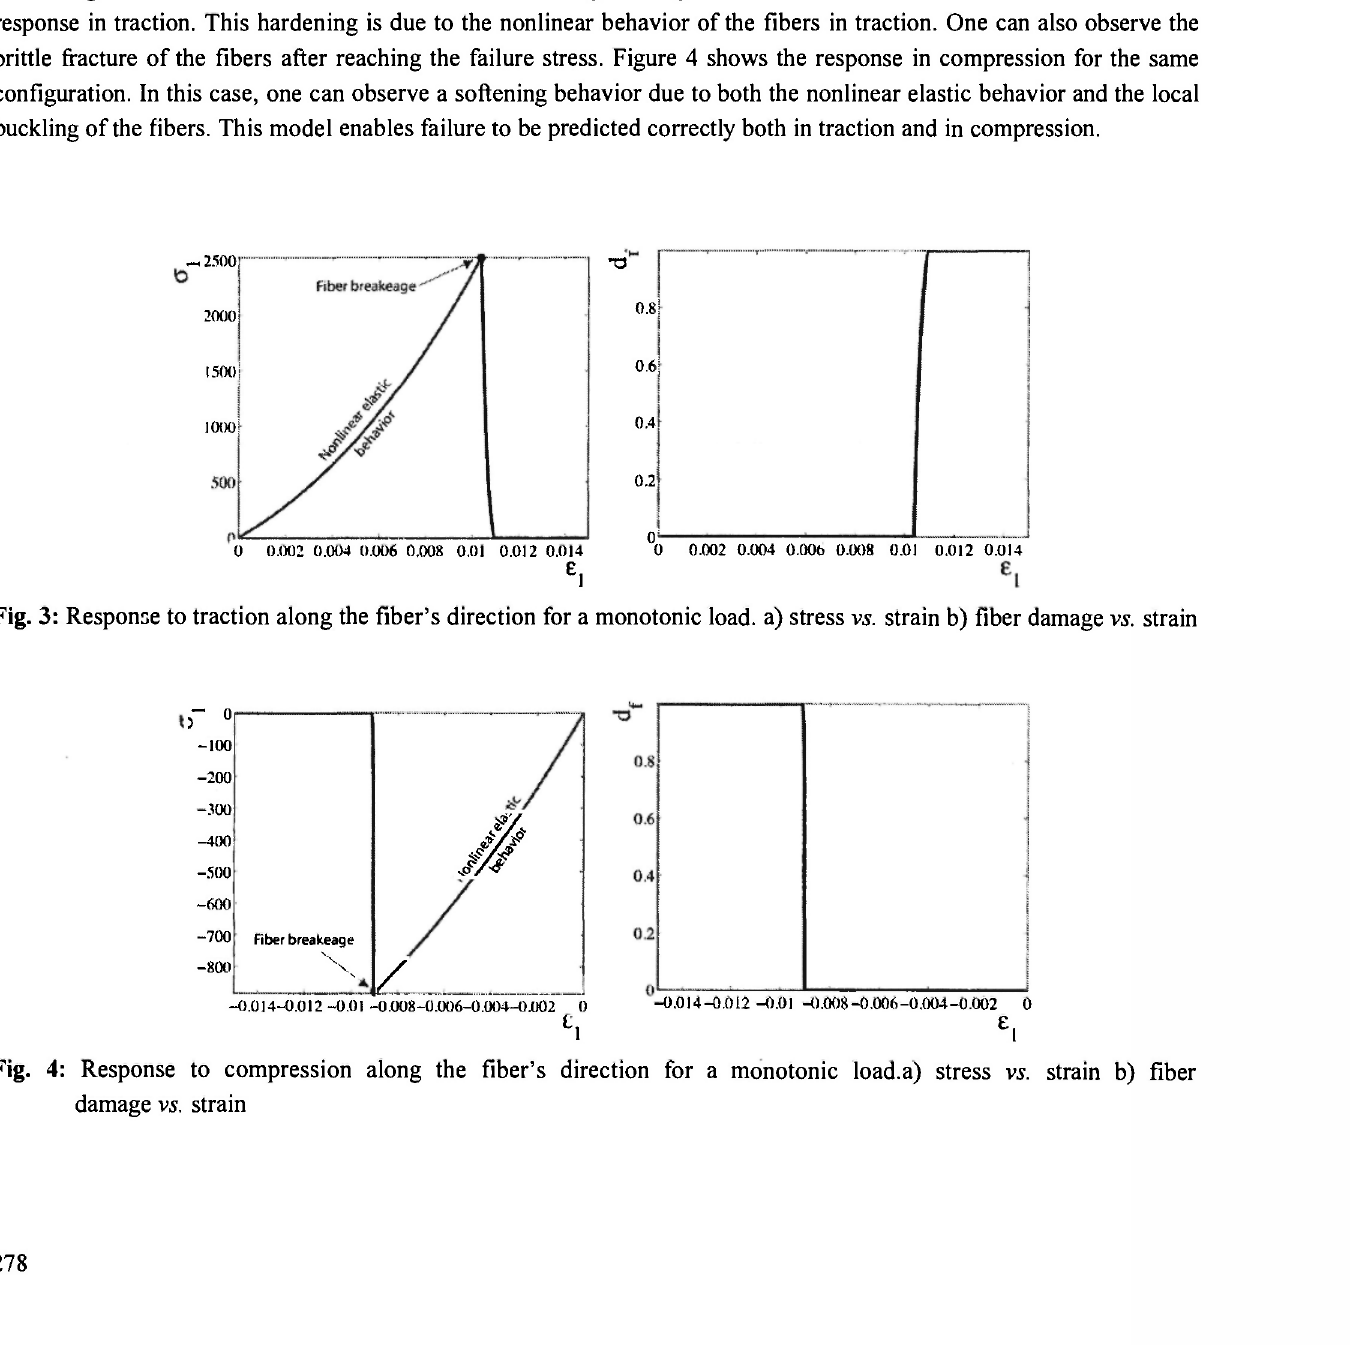
Fig. 4: Response to compression along the fiber's direction for a monotonic load.a) stress v.s. strain b) fiber damage vs.